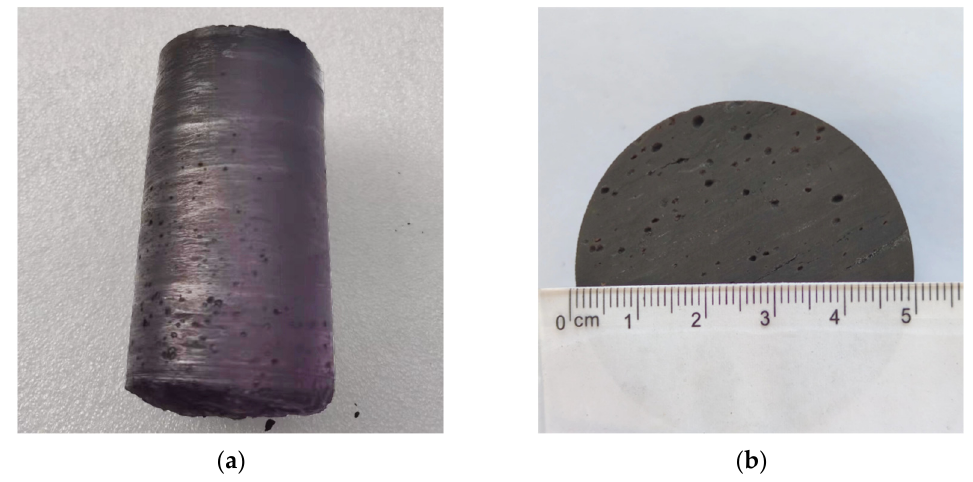
Figure 1. Photograph of a coal rock sample from a mine in Shanxi. ( a ) Photographed at 45° above oblique; ( b ) End view of the coal sample.